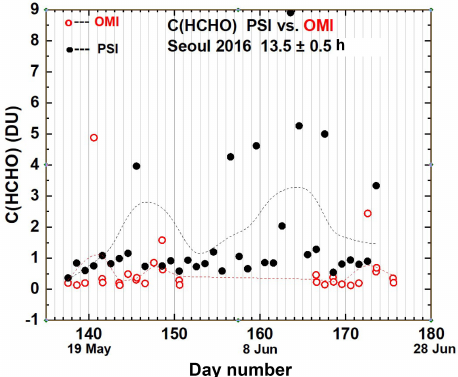
Figure 21. Compare PSI (bullet) and OMI (red circles) retrievals of C(HCHO) at 13 . 30 ± 0 . 5KST. OMI overpass data, V03, are from https://avdc.gsfc.nasa.gov/index.php?site=1113974256&id= 81 (last access: 31 July